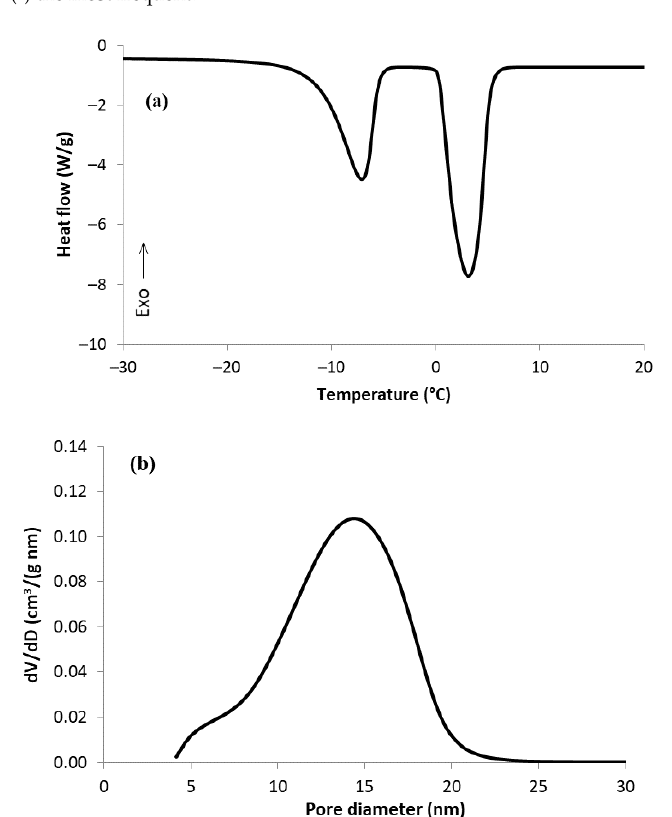
Figure 3. Nitrogen adsorption at −1 96 °C (solid circles) and desorption (empty circles) isotherms on MC sample ( a ), semi-logarithmic pore size distribution obtained by DFT method ( b ), and corre- sponding cumulated surface area (black) and pore volume (red) ( c ). Both the TPM and N 2 adsorption techniques undoubtedly show the mesoporous character of the MC sample and are in good agreement, regarding its high mesoporous volume.